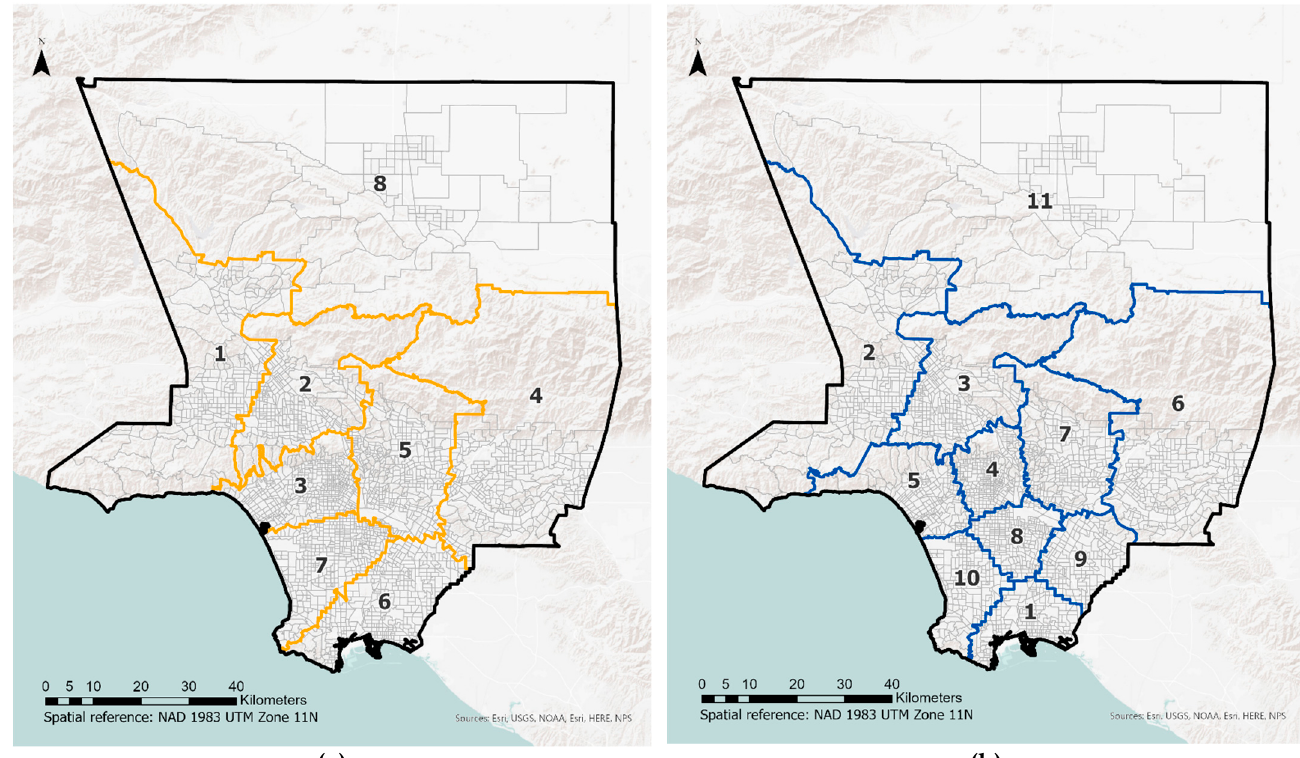
Figure 5. Earthquake relief zones in ( a ) No Tsunami Scenario and ( b ) Tsunami Scenario.